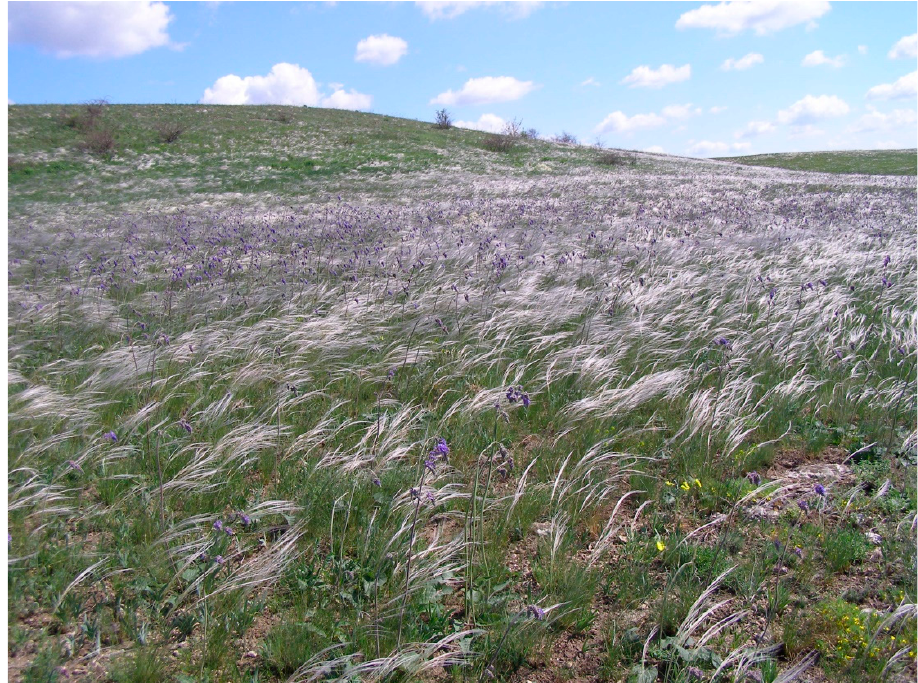
Figure 23. A fragment of the zonal steppe community of Stipo lessingianae-Salvietum nutantis as- sociation in the second year after autumn–winter burning of the herbage (surroundings of No- vokubanka